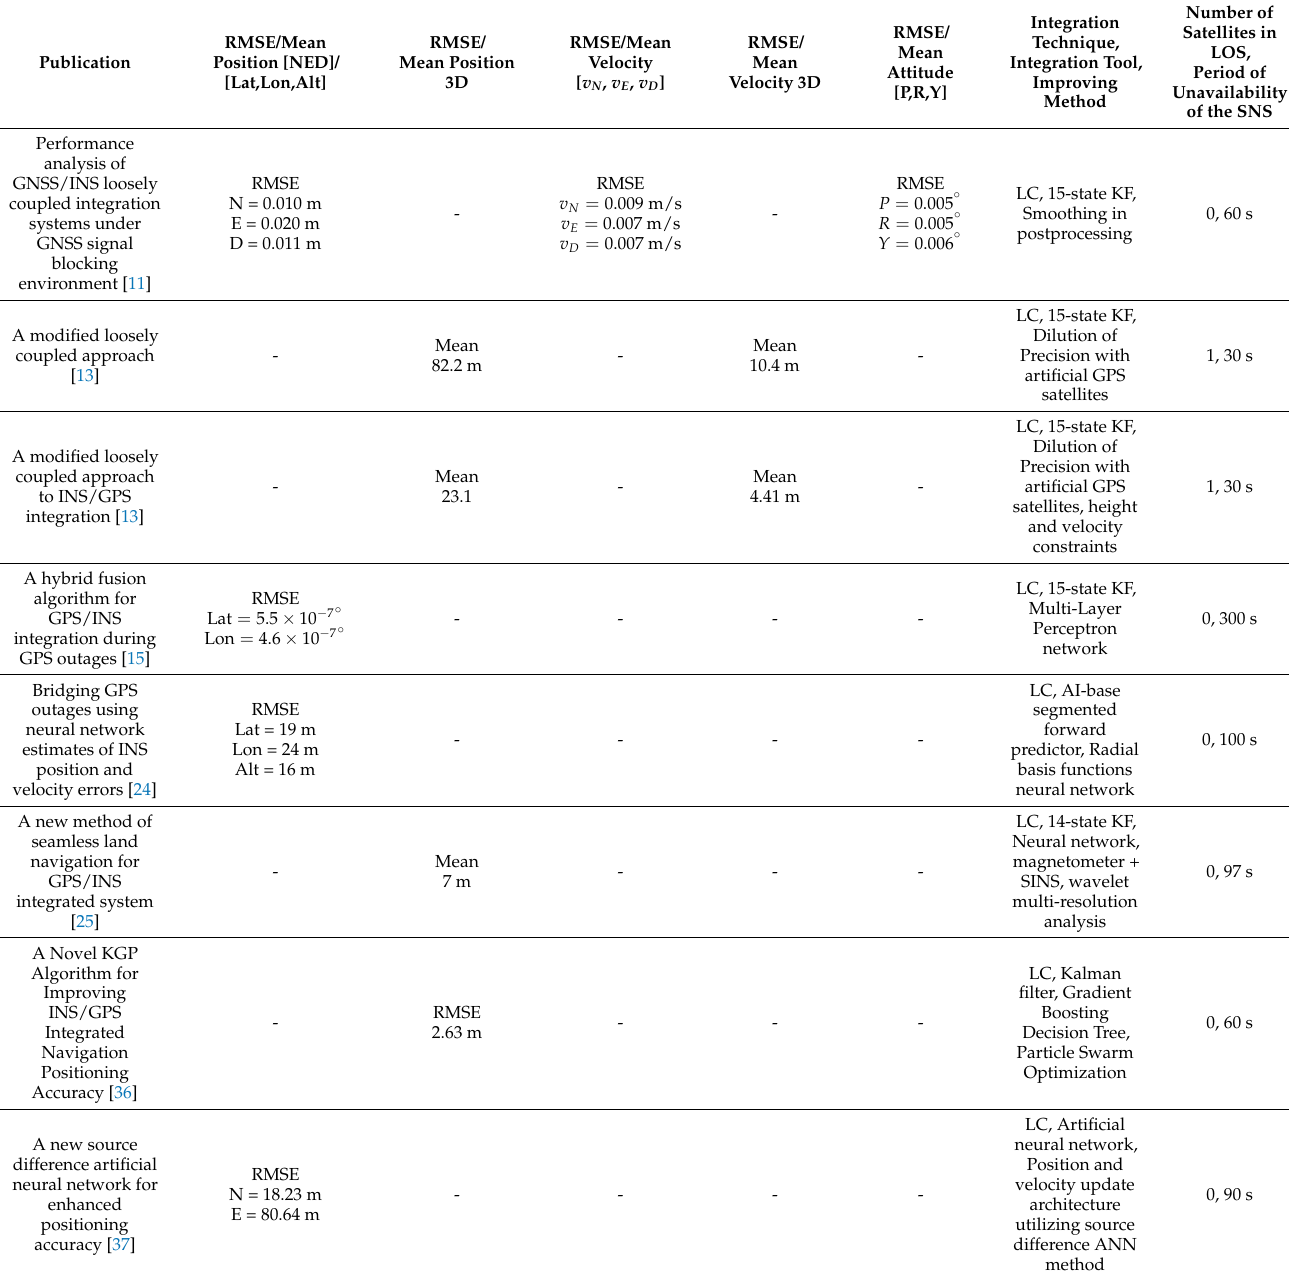
Table 3. Comparative characteristics of various approaches to the implementation of integrated INS/GNSS systems with complete or partial unavailability of GNSS